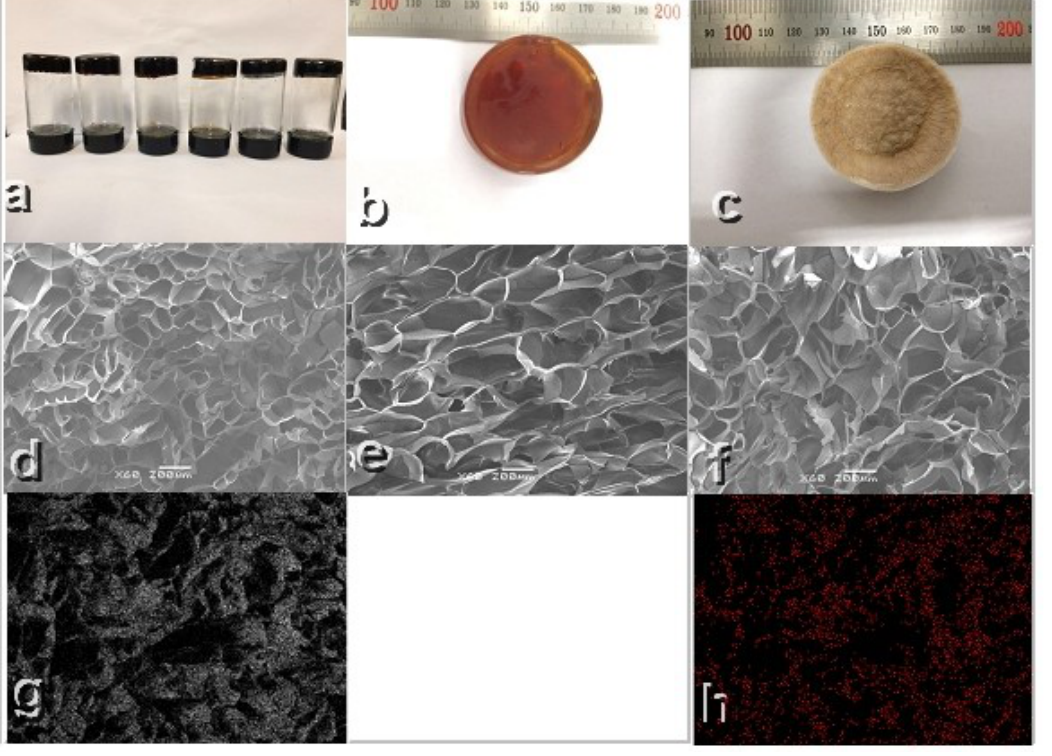
Figure 1. ( a ) Formed wet gel: 1:24 mass ratio; ( b ) swelling gel in deionized water: 1:24 mass ratio; ( c ) cryogel: 1:24 mass ratio. The SEM images of gels with ( d ) 1:24, ( e ) 1:12, and ( f ) 1:8 mass ratios. EDS images of 1:24 gel mass ratio: ( g ) carbon; ( h ) nitrogen.